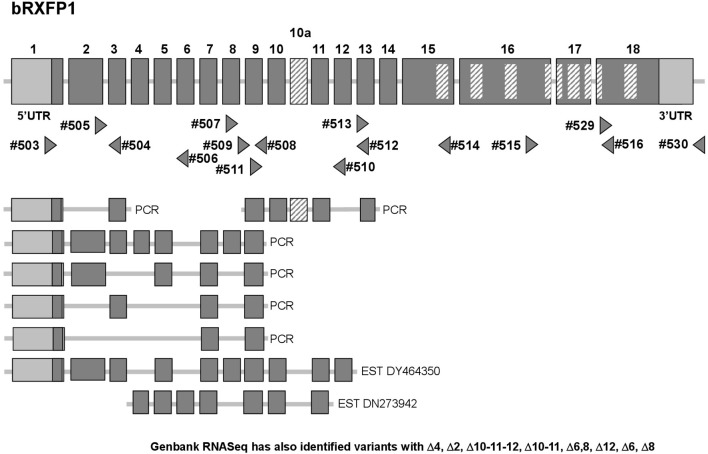
Schematic exon organization of the bovine RXFP1 gene (above) indicating both the position of the novel exon 10a and the locations of the oligonucleotide primers (triangles) used for RT-PCR analysis. The locations of encoded transmembrane regions are indicated by the internal cross-hatched rectangles. The corresponding exon structures of various splice variants identified in this study by RT-PCR, or as pre-existing EST sequences, are indicated below. Additionally, RNASeq analysis (NCBI database; release Dec. 2016) has identified splice variants with the following deletions: Δ4, Δ2, Δ10-11-12, Δ10-11, Δ6, 8, Δ12, Δ6, Δ8.